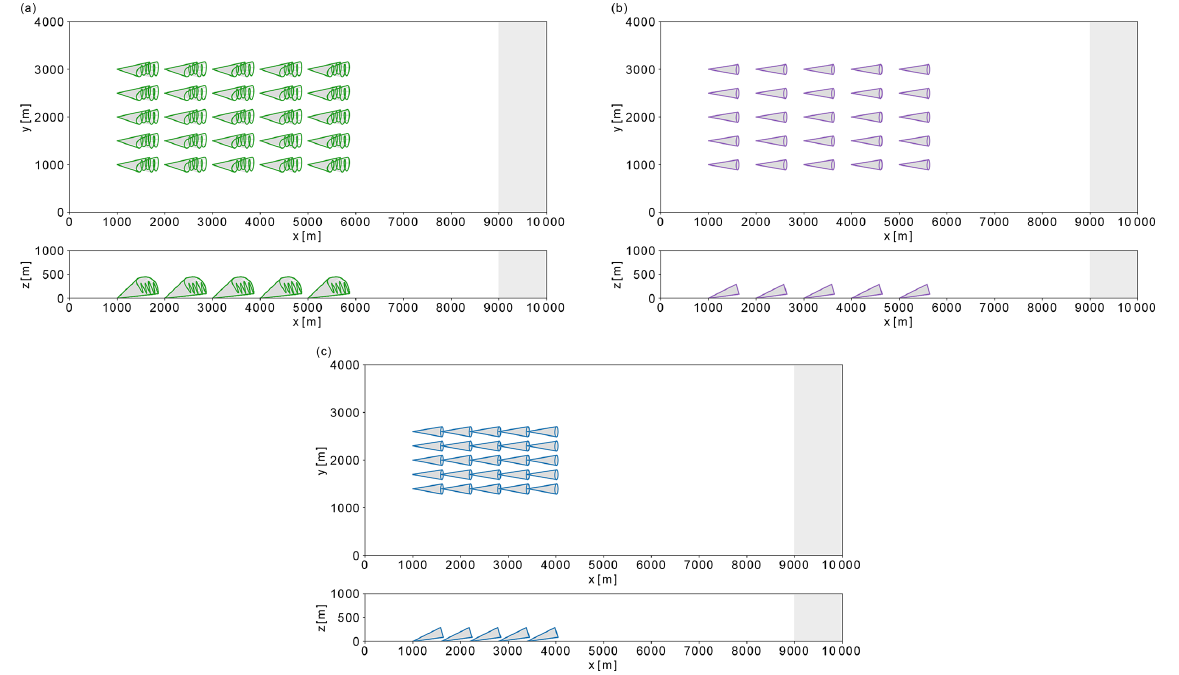
Figure 11. Visualisations of top and side views of AWE park layouts in the main LES domain. (a) Lift-mode AWE park with layout 1 (L1), (b) drag-mode AWE park with layout 1 (D1), and (c) drag-mode AWE park with layout 2 (D2). The grey area represents the fringe region required for inflow recycling from the precursor